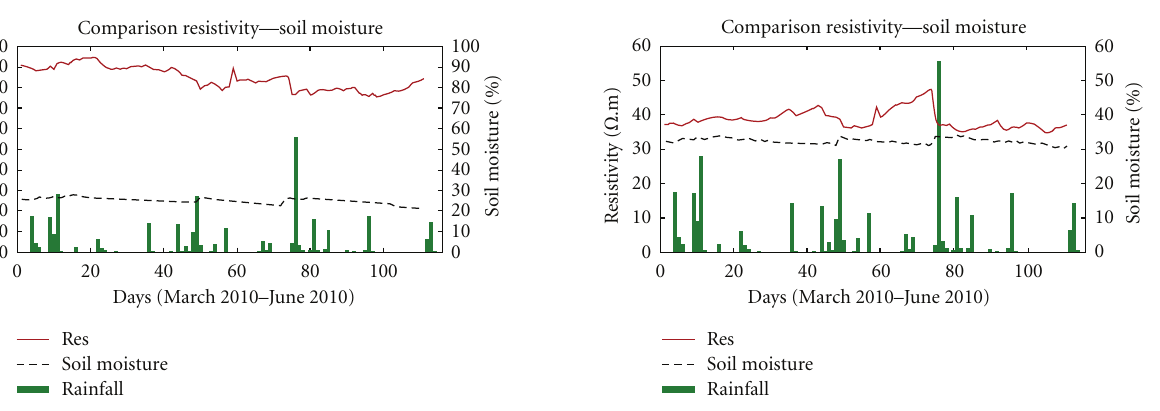
Figure 16: Comparison between Resistivity and TDR acquired at 1.5m depth, in correspondence of the 35th